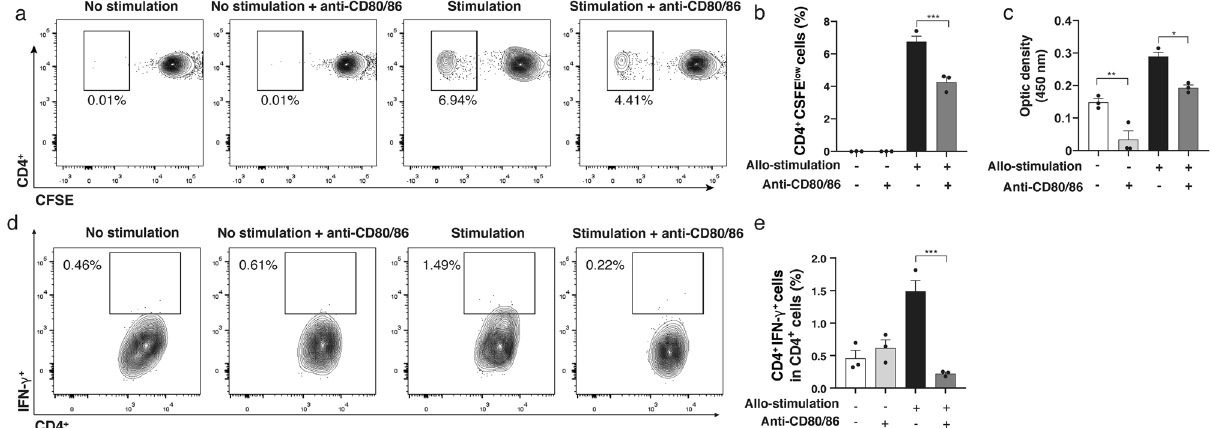
Figure 1. Anti-CD80/86 antibodies suppress T lymphocyte proliferation in mixed lymphocyte reaction assay. Representative flow cytometry plots of CD4 + ( a ) CFSE-labeled cells. ( b ) The frequency of CD4 + CFSE low cells in CD4 + T cells was significantly reduced in the allogeneic stimulation group with anti-CD80/86 antibodies compared with that in without anti-CD80/86 antibodies group (n = 3, *** P < 0.001). ( c ) Representative columns of BrdU assay results. Anti-CD80/86 suppressed T cell proliferation compared to without anti-CD80/86 antibodies in allogeneic stimulation and no allogeneic stimulation (n = 3, ** P = 0.007, * P = 0.019, respectively). ( d ) Representative flow cytometry plots of the frequency of IFN-γ + CD4 + T lymphocyte with or without allogeneic stimulation and anti-CD80/86 intervention. ( e ) Frequency of IFN-γ + CD4 + T lymphocyte in CD4 + T cells reduced following treatment with anti-CD80/86 antibodies compared with that without anti-CD80/86 antibody treatment in allogeneic stimulation (n = 3, * P < 0.001). Data are presented as mean ± SEM. CFSE carboxyfluorescein diacetate succinimidyl